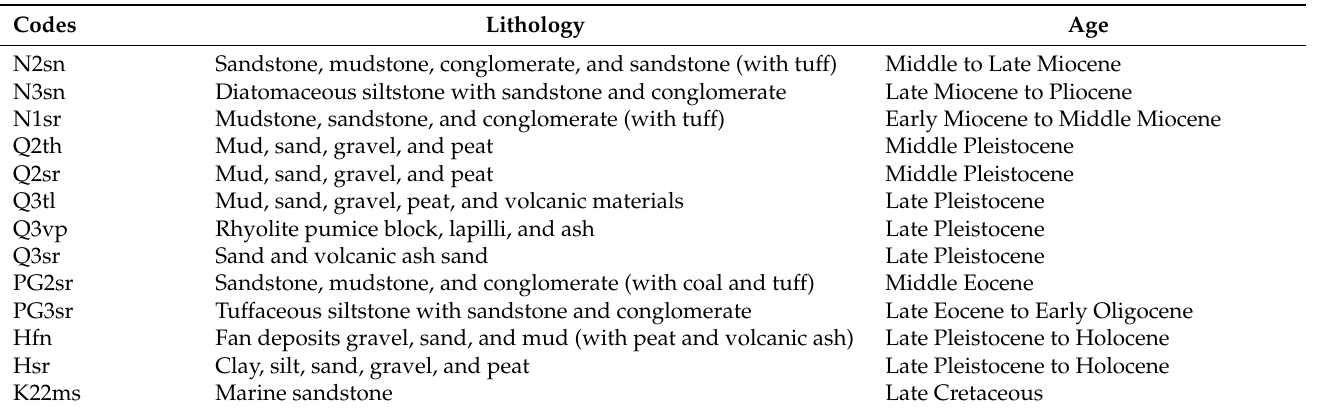
Table 1. Geological unit